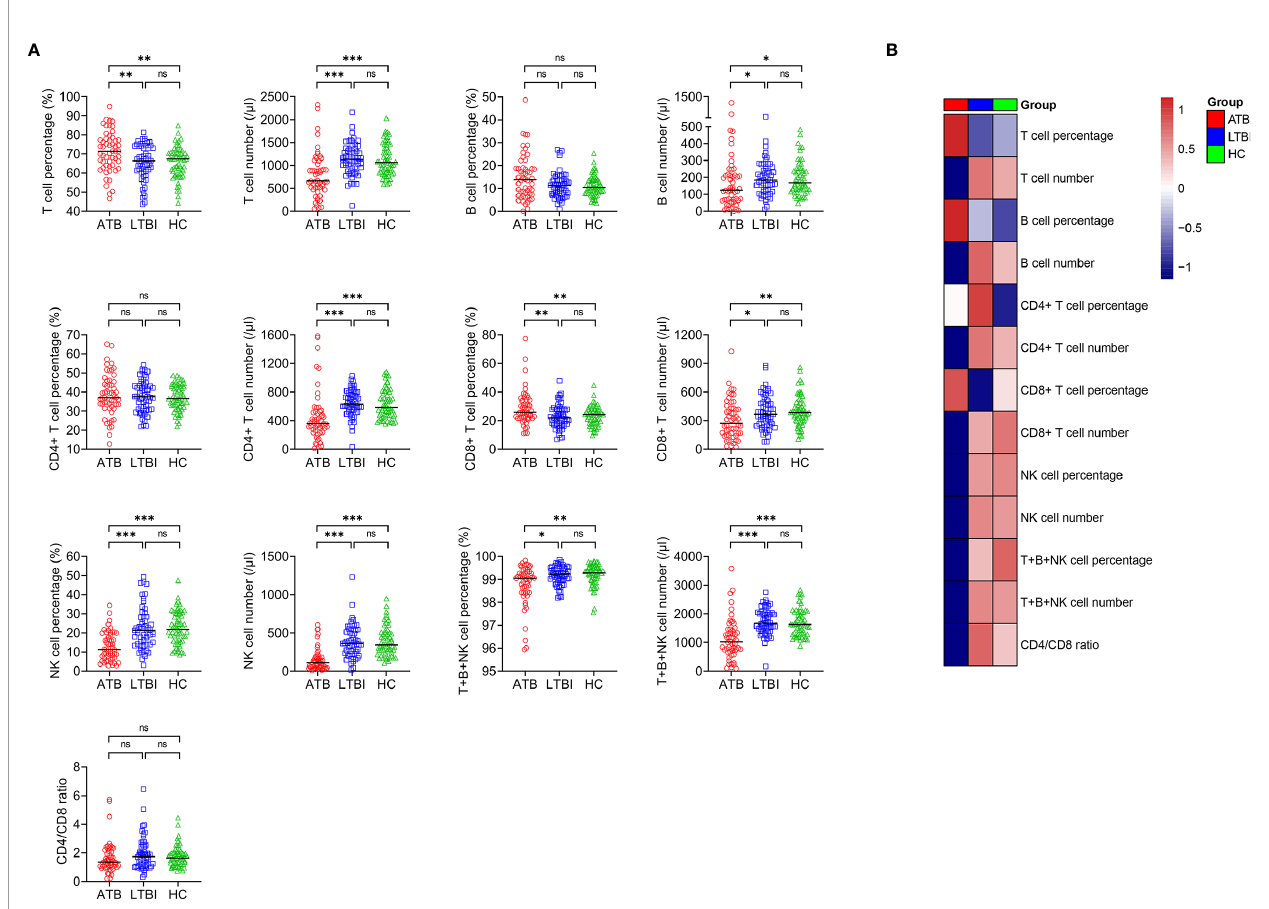
FIGURE 2 | The results of lymphocyte subsets in ATB, LTBI, and HC. (A) Scatter plots showing the results of lymphocyte subsets in ATB (n = 54), LTBI (n = 57), and HC (n = 60). Horizontal lines indicate the median. * P < 0.05, ** P < 0.01, *** P < 0.001, ns, no signi fi cance (Mann-Whitney U test). (B) Heatmap showing the results of lymphocyte subsets in ATB group, LTBI group, and HC group. Each rectangle indicates the median result of a group. ATB, active tuberculosis; LTBI, latent tuberculosis infection; HC, healthy